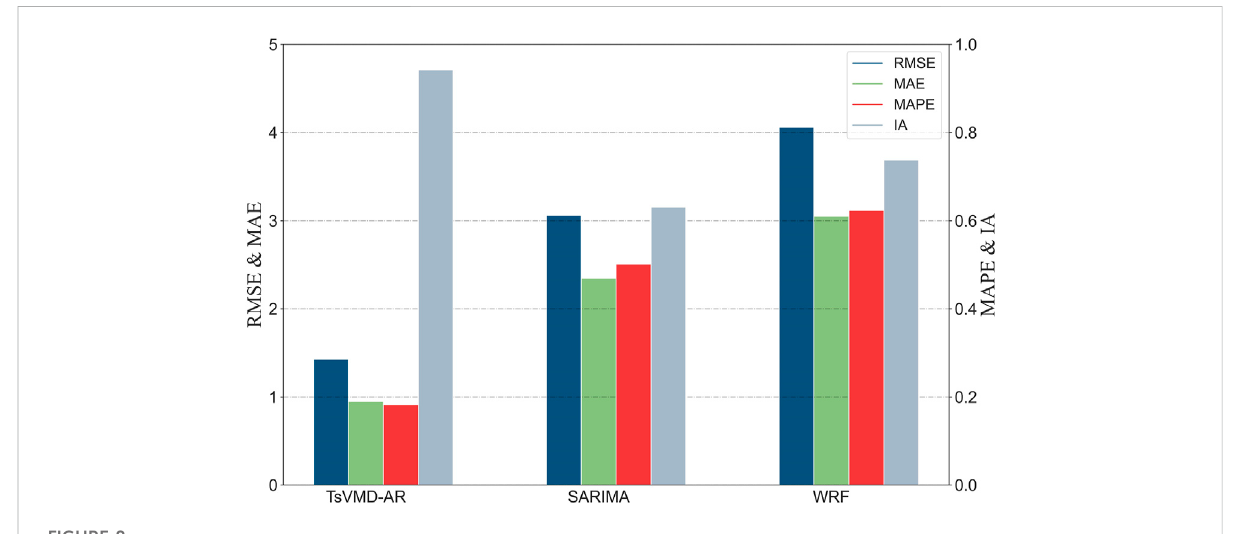
FIGURE 8 Evaluation criteria results of different forecasting models for period